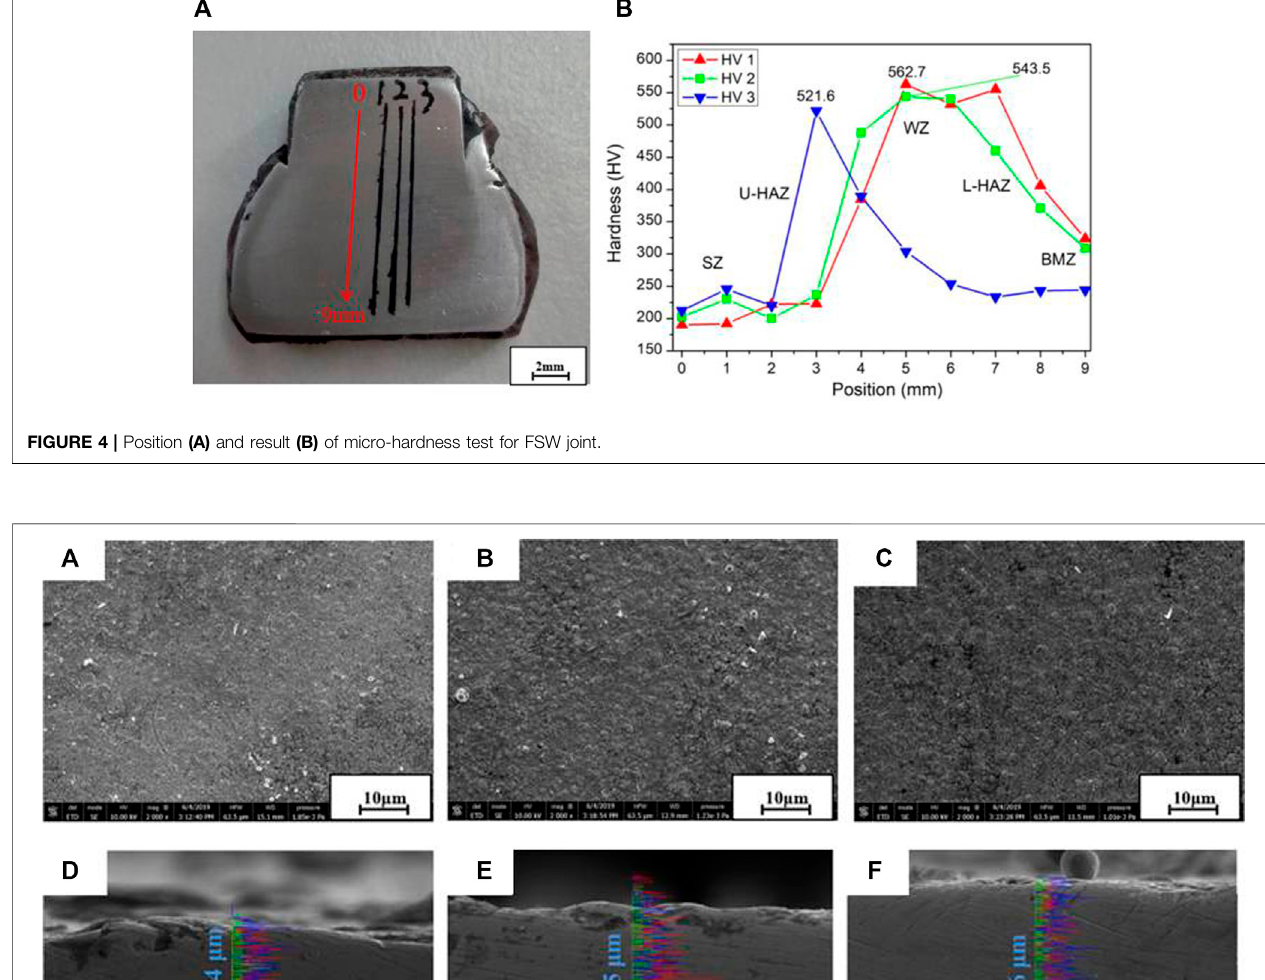
Frontiers in Materials |